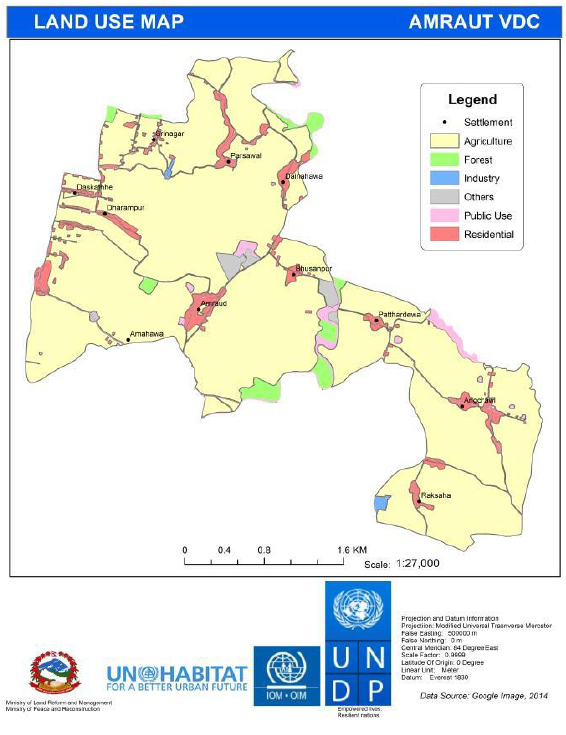
Figure 9. Land use Map of Amraut